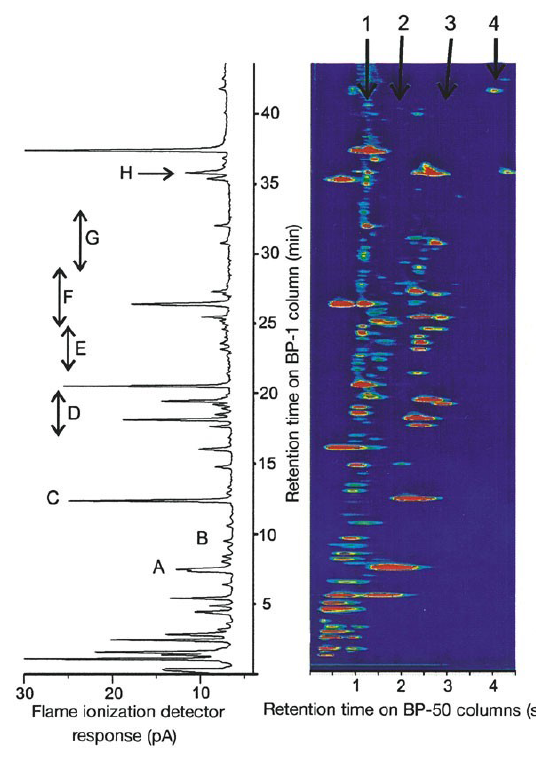
Figure 13. Comprehensive (right) and one-dimensional (left) sepa- rations of volatile organic compounds in urban air, demonstrating a greater variety and number of VOCs (Lewis et al.,